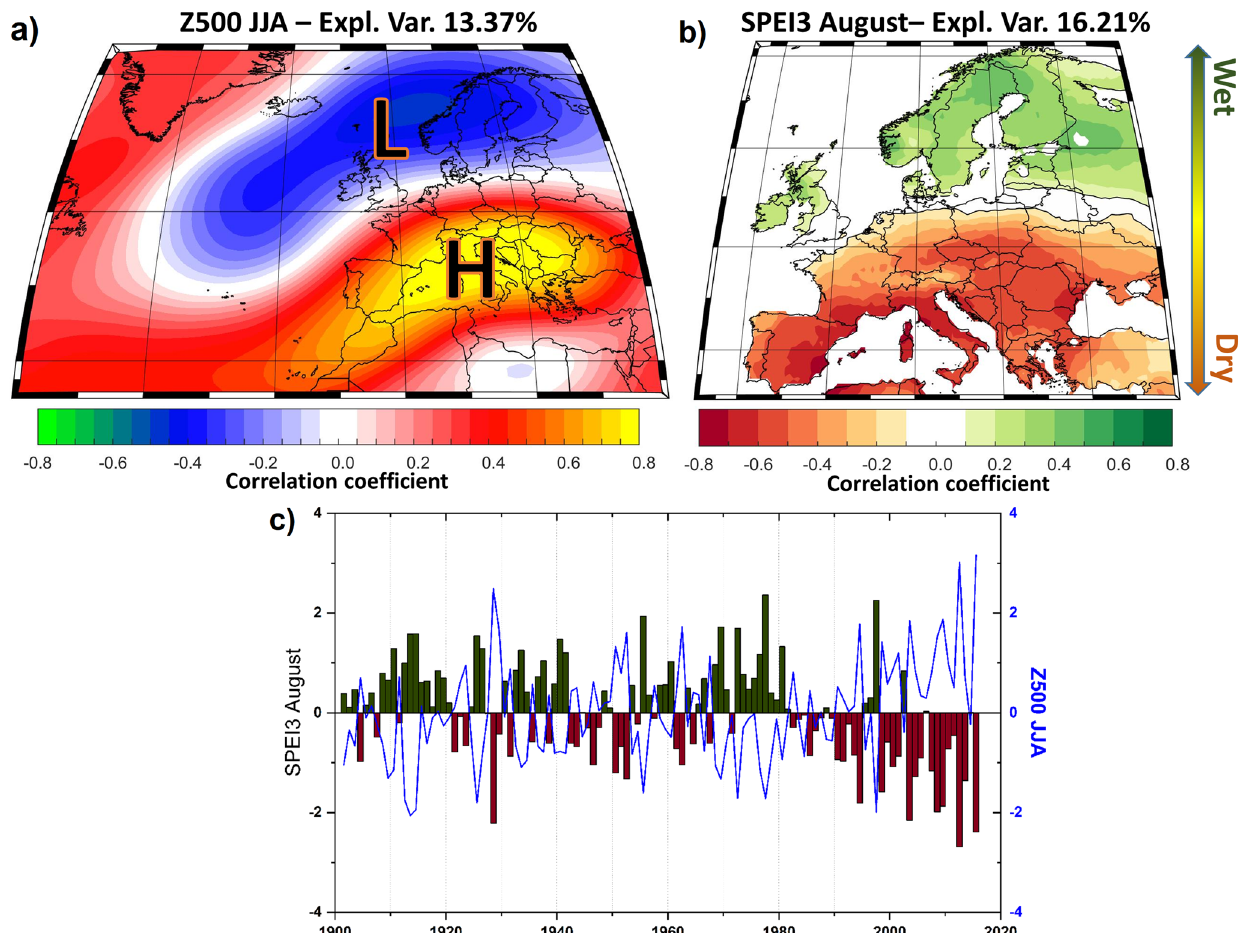
Fig. 2 Coupled modes of variability. The fi rst coupled mode of variability (CCA1) between a summer Z500 and b August SPEI3; c the standardized amplitudes corresponding to CCA1-Z500 (blue line) and CCA-SPEI3